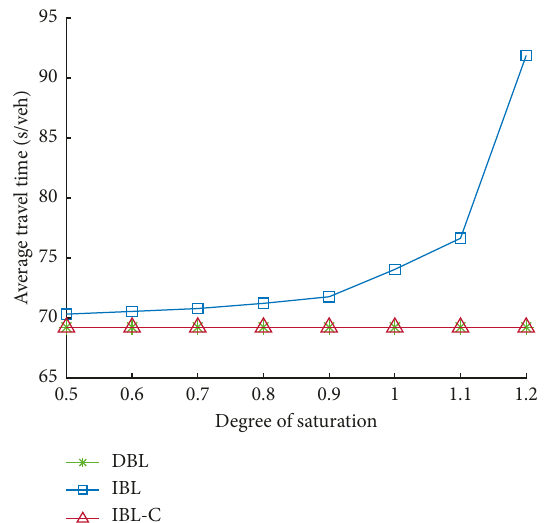
Figure 7: Average traffic time of bus when the interval of buses is random.